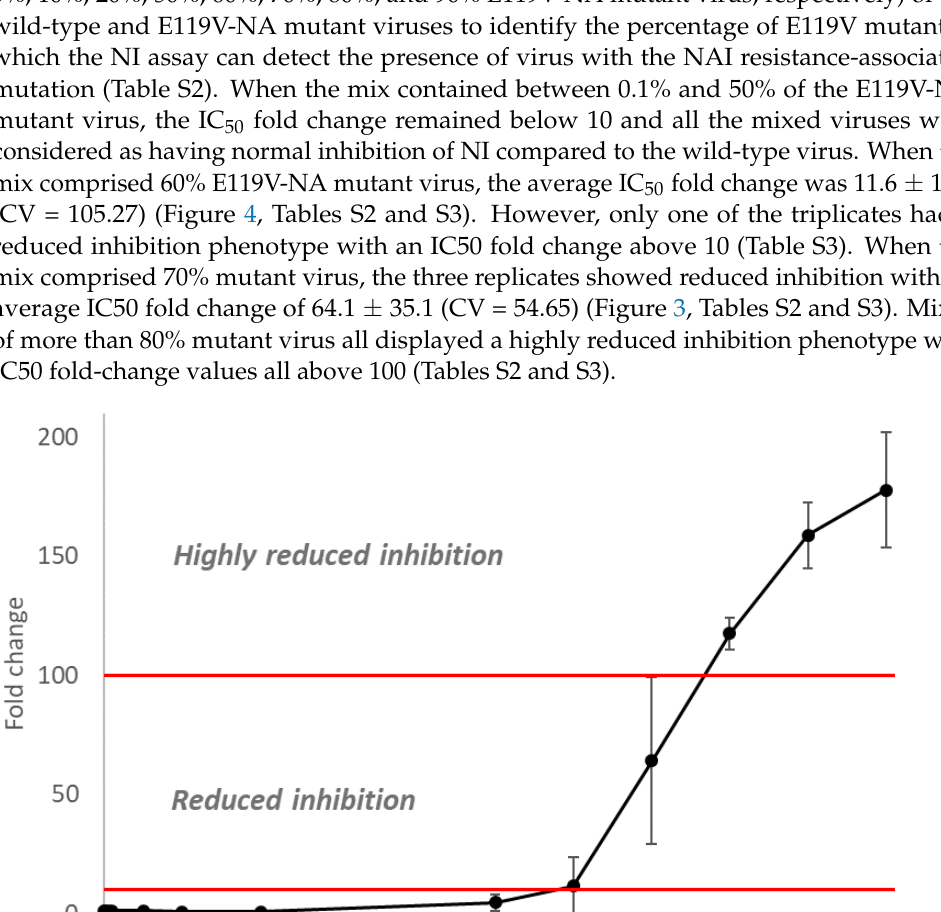
-resistant recombinant influenza H3N2 viruses with the E119V-NA mutation . To compare the Figure 4. Inhibitory activity of oseltamivir on mixed populations of NAI-susceptible and -re-